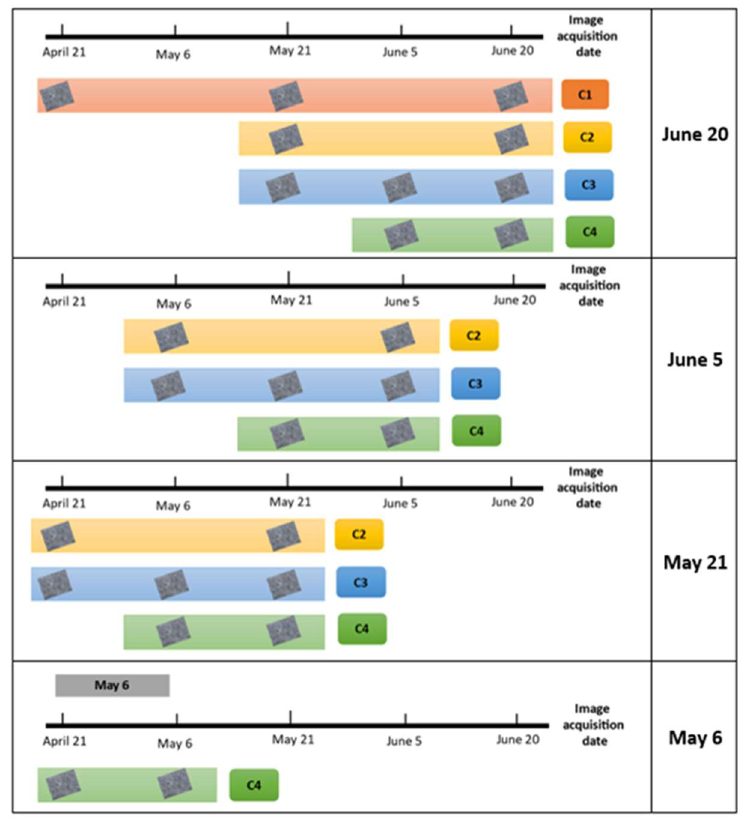
Figure 11. Number and date of images used to validate the models in the next crop